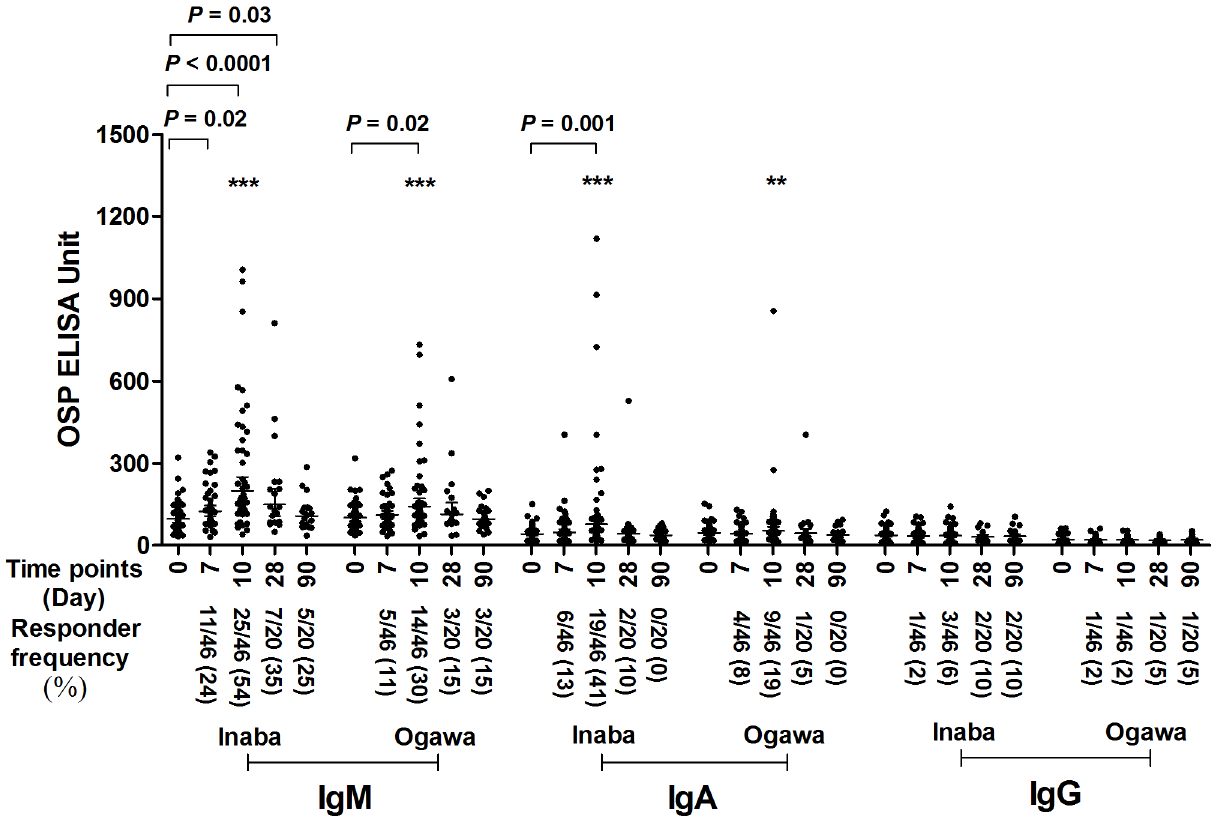
Fig 1. Serum IgM, IgA and IgG responses targeting V . cholerae O1 Inaba or Ogawa OSP in vaccine recipients of CVD 103-HgR. Figure only contains results for samples collected prior to wild type experimental V . cholerae challenge. Day 0 is pre-vaccination and other dates are timed from vaccination. In total, 46 vaccinees are included until day 10, then 20 vaccinees until day 90. X axis indicates the time points of samples while Y-axis denotes OSP-specific antibody responses. Each single dot indicates an individual OSP antibody value, horizontal bars indicate the geometric mean (GM), and error bars indicate 95% confidence intervals. P values represent significant differences of the mean between groups. Asterisks represent differences in responder frequency in Fisher’s exact test ( (cid:3)(cid:3)(cid:3) P (cid:20) 0.001, (cid:3)(cid:3) P (cid:20) 0.01). We defined a responder as having a (cid:21) 1.5-fold increase in anti-OSP units after vaccination compared to pre-vaccination value. Responder frequency is represented in parenthesis on